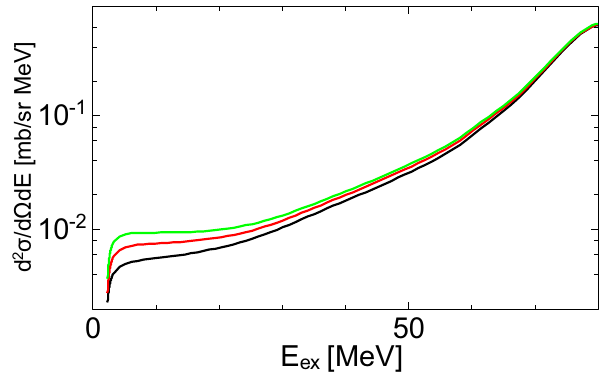
Figure 3: Cross section for inclusive breakup reaction, 2 H ( p , p (cid:48) ) pn , for proton = 170 MeV as a function of excitation energy of the scattering angle 110 ◦ at E p residual pn system. Black, red, and green curves denote AV18, AV18 + BR AV18 + BR(C) calculations, 1000